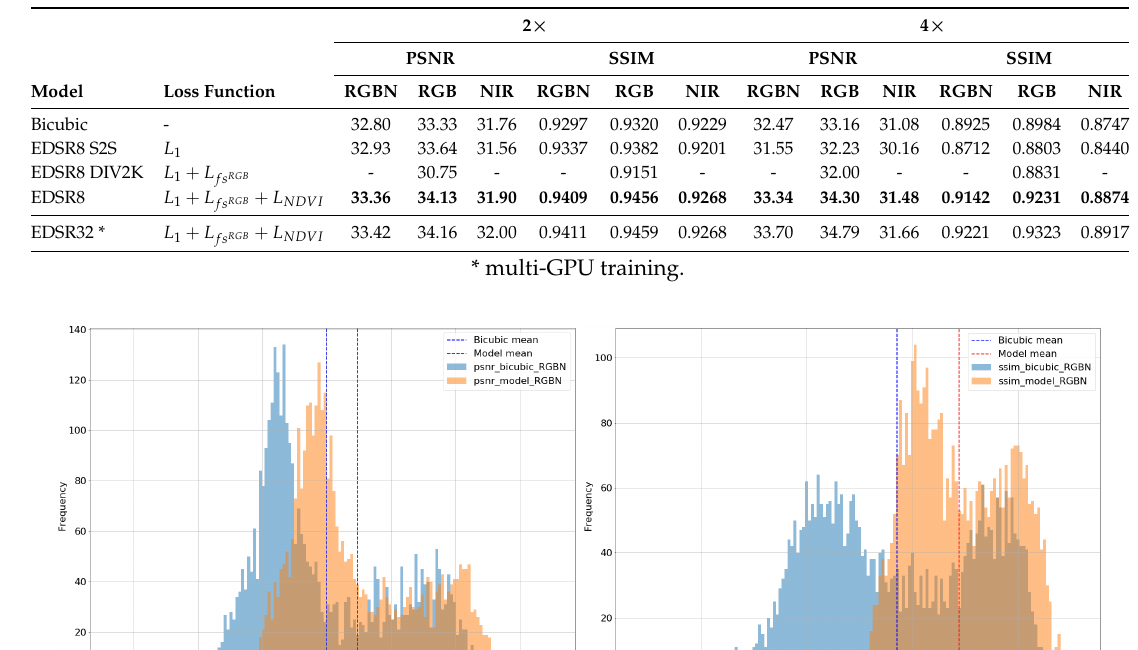
Table 12. PSNR and SSIM metrics obtained for the proposed and baseline models in the test set.